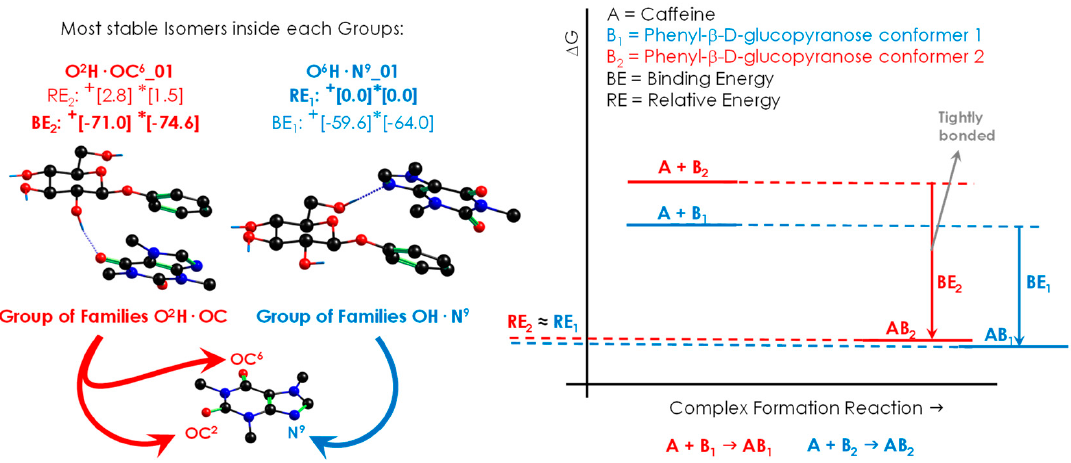
Figure 3. Most stable structures of Caf+PhGlc. Energy values (kJ/mol) are given for the two different computational methods used: (+) M06-2X/6-311++G(d,p) and (*) B3LYP-GD3BJ/def2TZVP. The first couple of values for each method refers to the relative energy (RE) while the second one is the binding energy (BE), calculated at 0 K. RE X refers to the energy of the complex X minus the energy of the most stable complex. BE X refers to the energy of the complex X minus the energy of the sum of the monomers in the most similar arrangement as present in the complex. The label of each structure uses as reference the main interaction forming the complex. The label of the most stable (RE: O 6 H·N 9 _01) and that of the most strongly bonded structures (BE: O 2 H·OC 6 _01 with O 2 H·OC 2 _01) are in bold. The rich collection of interactions displayed on the iPES results in a group of